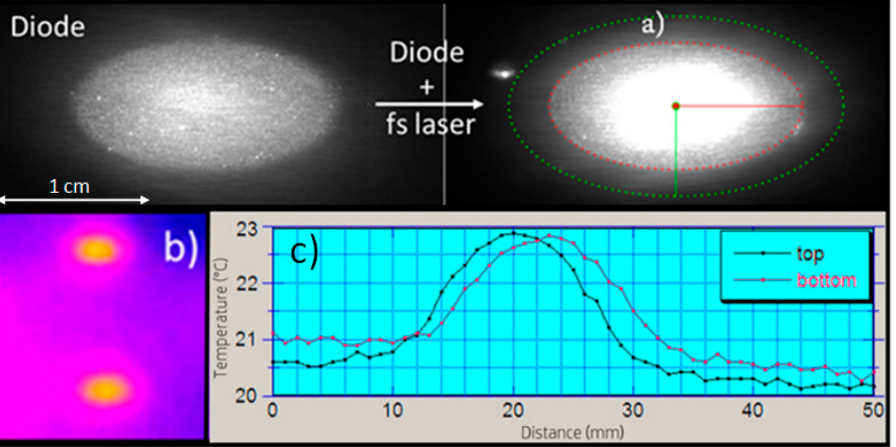
Figure 10. ( a ) Image of the heating diode laser beam and of the fs laser beam on G1. The laser diode beam has a top hat profile, with a spot size of 0.82 cm × 1.63 cm (surface ~ 1 cm 2 ). The edge of the diode beam is evidenced by a dashed red line, and the edge of the fs beam by a dashed green line. ( b ) G1 thermal image for 130W sent on each spot (see above). ( c ) Temperature profiles for the beam spots ( b ); left profile: input spot; right profile: output spot.